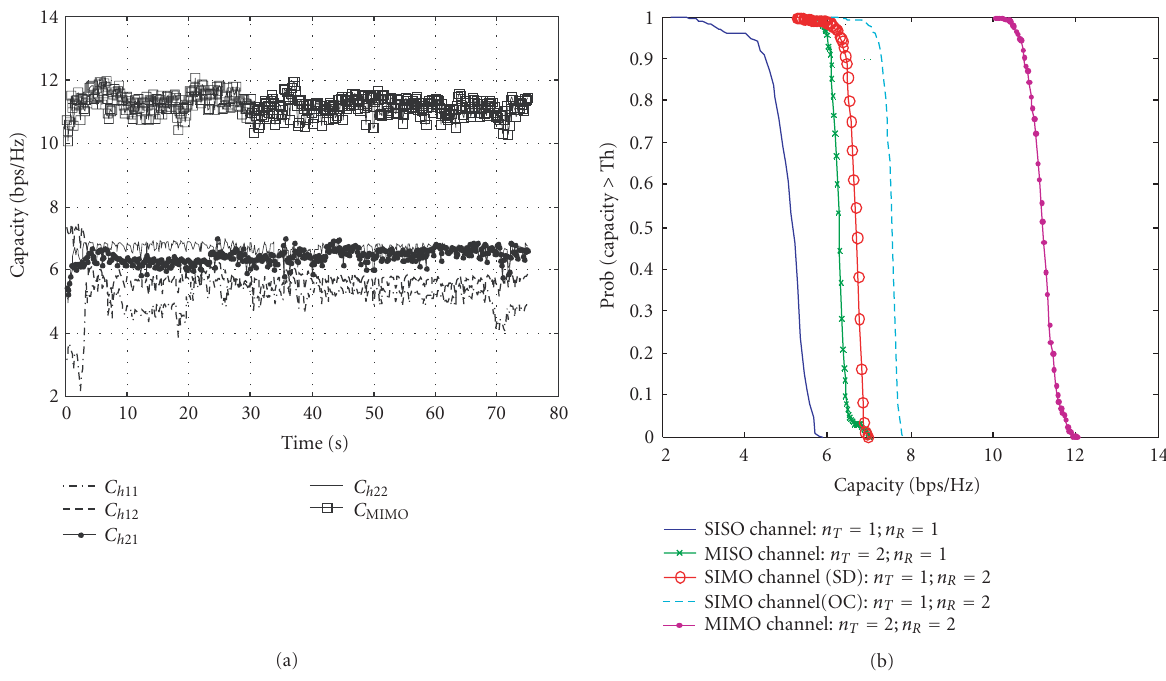
Figure 11: (a) Channel capacity; SISO versus MIMO channel. (b) CCDF plots of capacity for SISO, SIMO, MISO, and MIMO for 20dB